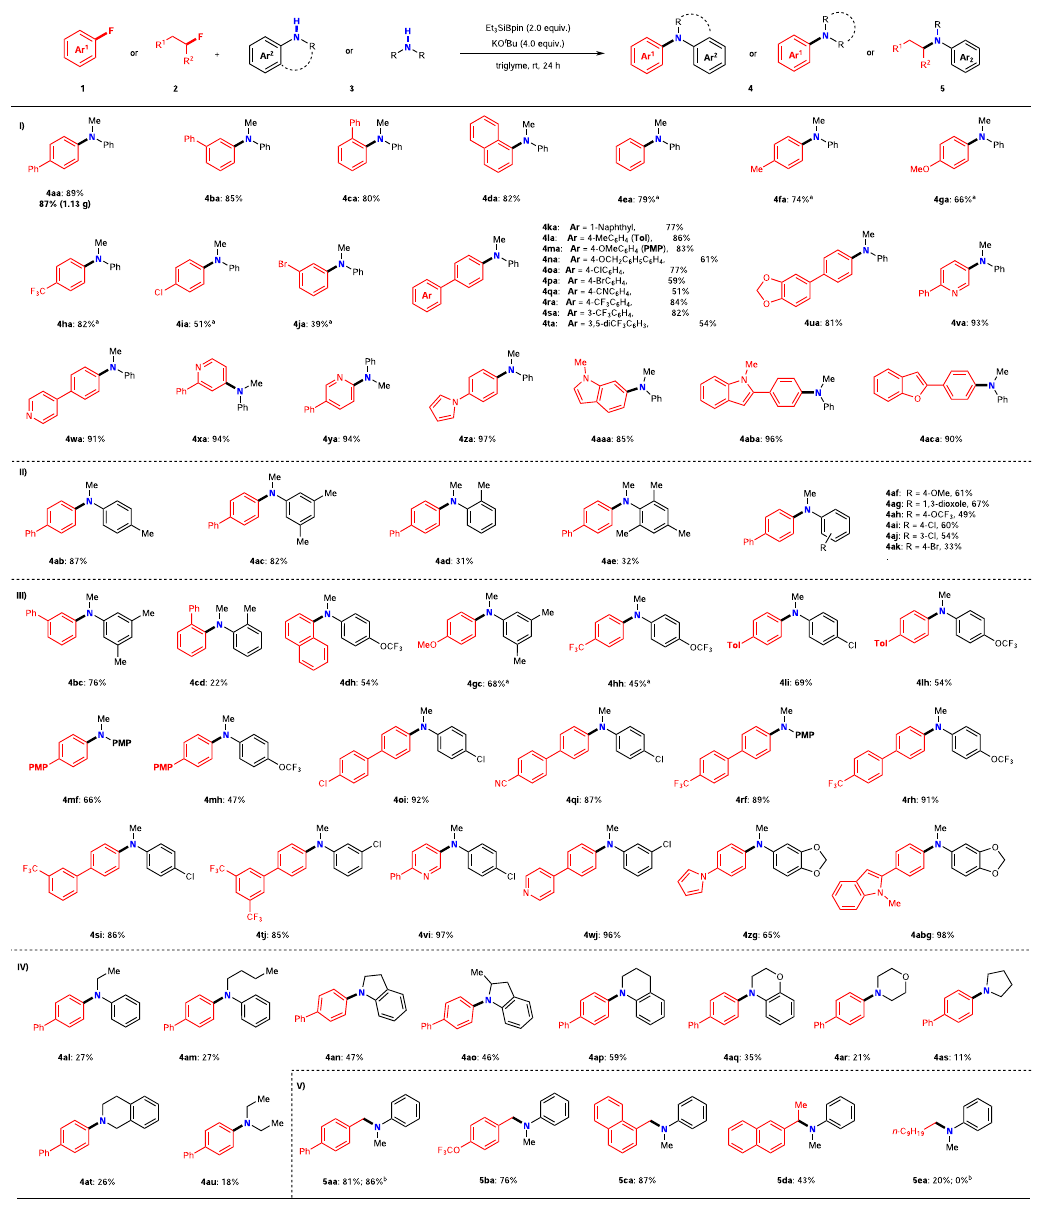
Fig. 2 | Substrate scope of 1, 2, and 3. Unless otherwise noted, all reactions were conducted using 1 or 2 (0.2mmol), 3 (3.0 equiv.), Et 3 SiBpin (96.8mg, 2.0 equiv.), KO t Bu (89.6mg, 4.0 equiv.), and triglyme (1.0mL) at room temperature for 24h,